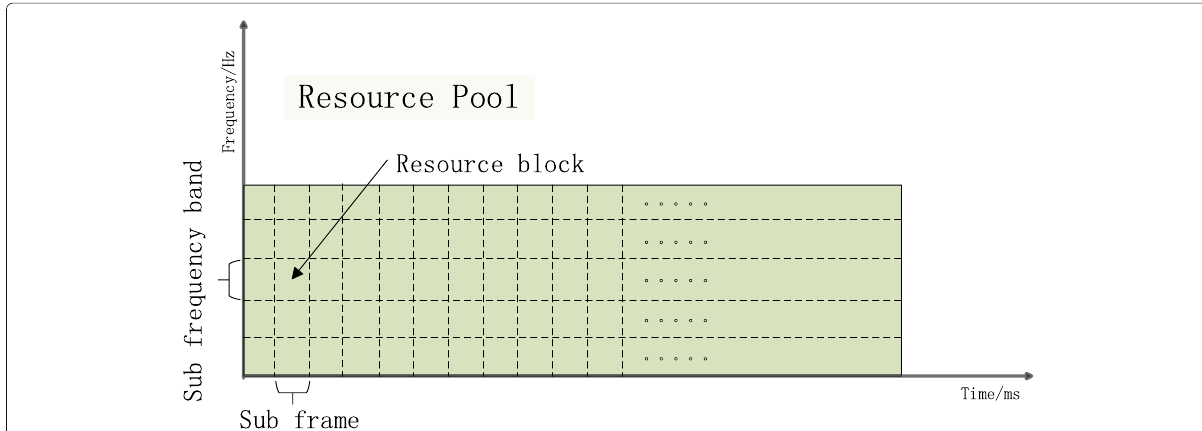
Fig. 3 The model of resource pool. The minimum unit in time domain is a subframe. The minimum unit in frequency domain is a sub frequency band. A specific subframe and a specific sub frequency band determine a resource block in the resource